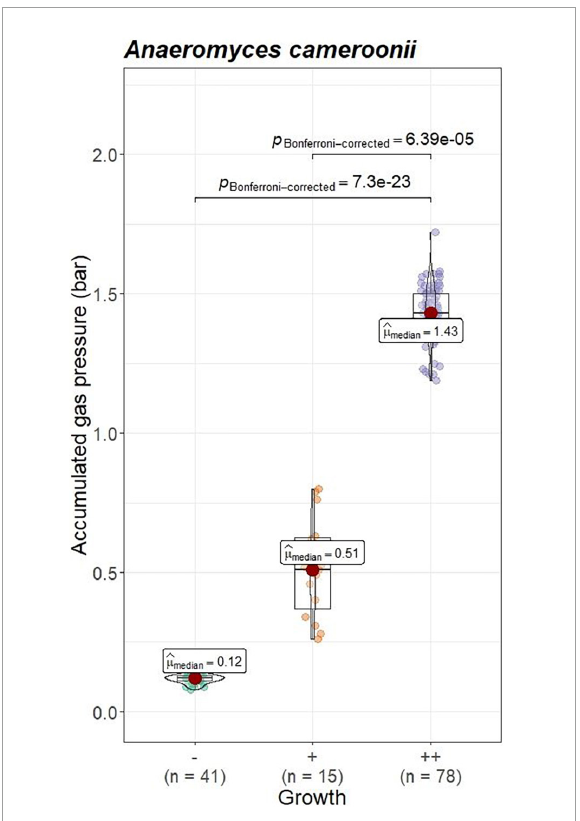
FIGURE9 Correlation between AF visual growth inspection and accumulated gas pressure at lab C. Visual growth evaluation categories: “–”, no growth; “++”, very good growth. Statistical tests: Kruskal–Wallis with post hoc Dunn-test. Only significant pairwise comparisons are